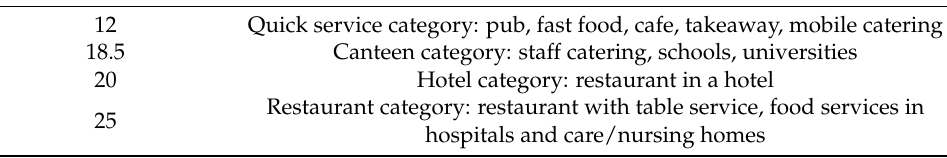
Restaurant category: restaurant with table service, food services in hospitals and care/nursing